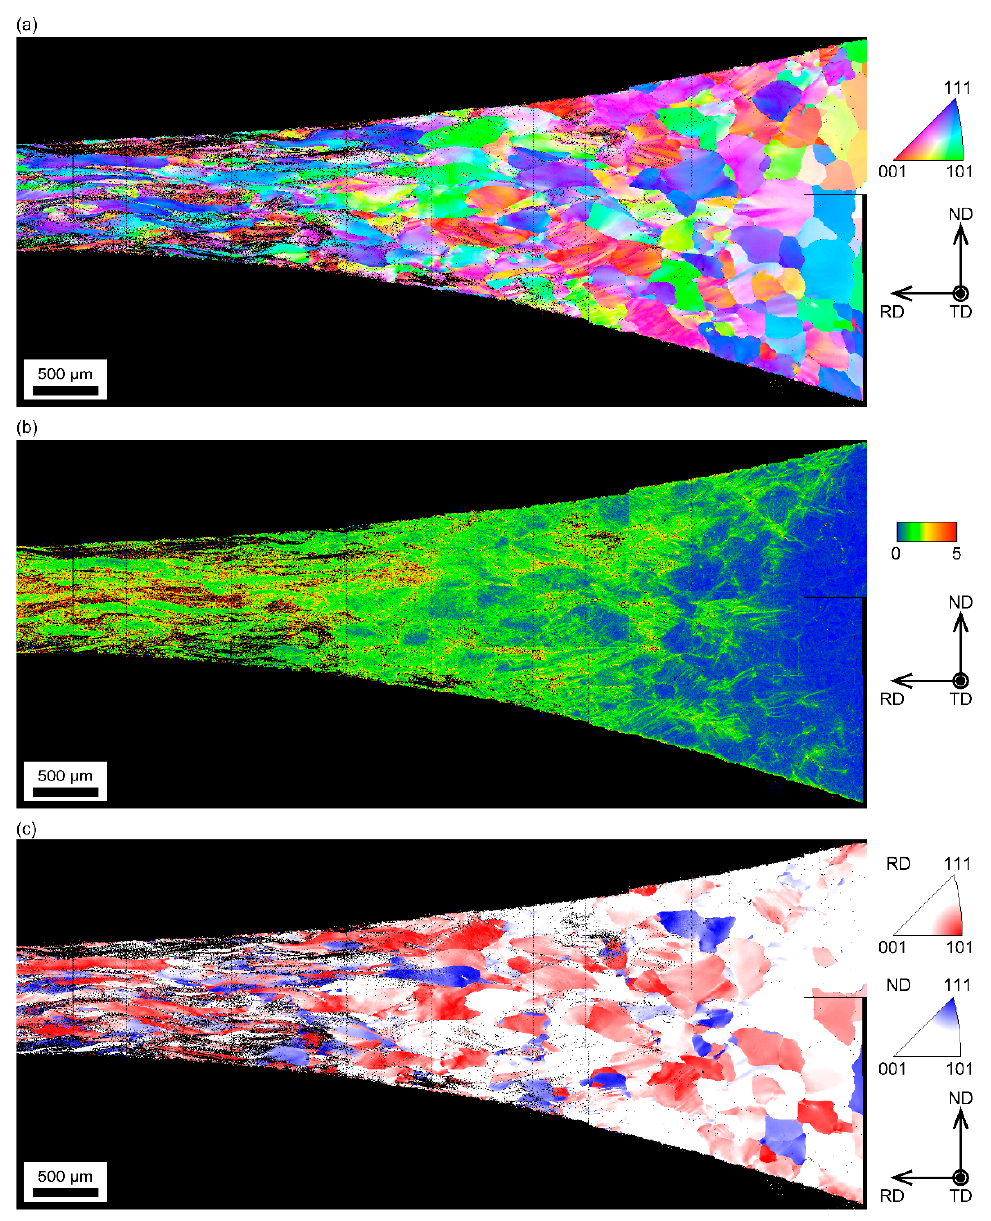
Figure 6. Microstructure of the half-rolled specimen. ( a ) IPF map for transverse direction (TD), ( b ) KAM map, and ( c ) crystal direction map for < 011 >// reference direction (RD) and < 111 >// normal direction (ND).